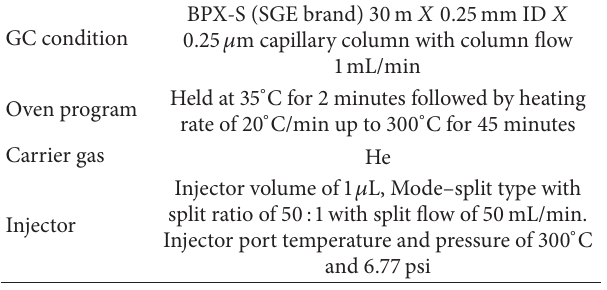
Table 2: Description of GC method used for tar analysis.